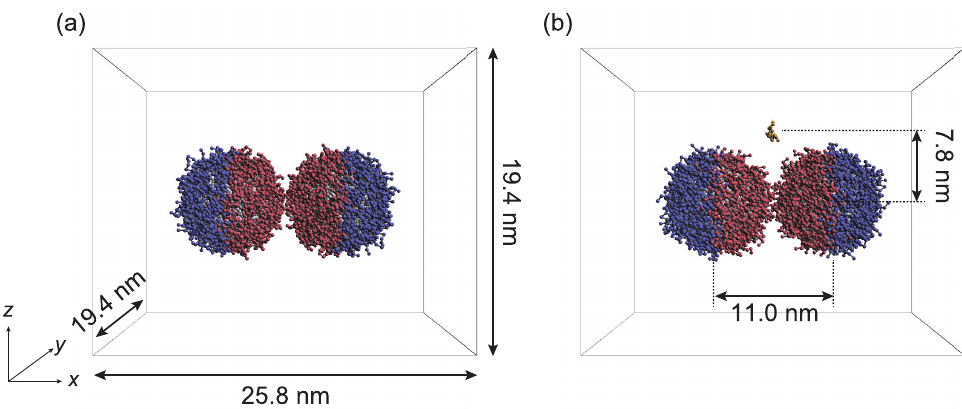
Figure 2. Initial configurations of PTNPs for simulations performed to ( a ) optimize their design and ( b ) determine their sensing capability. Solvent beads are not shown for